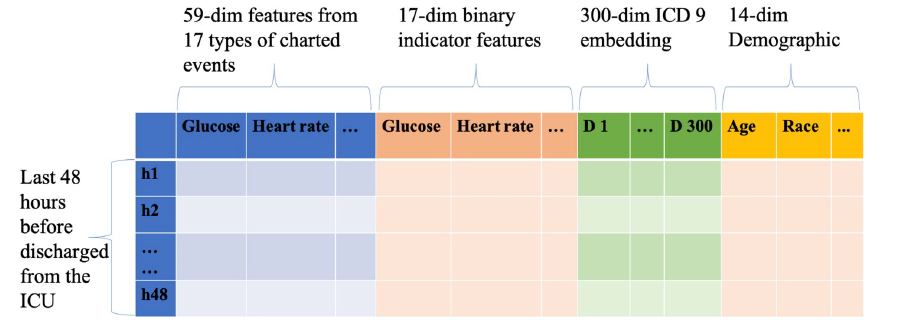
Fig 3. The data structure of input data used with CNN and LSTM models. D: dimension, h: hour.